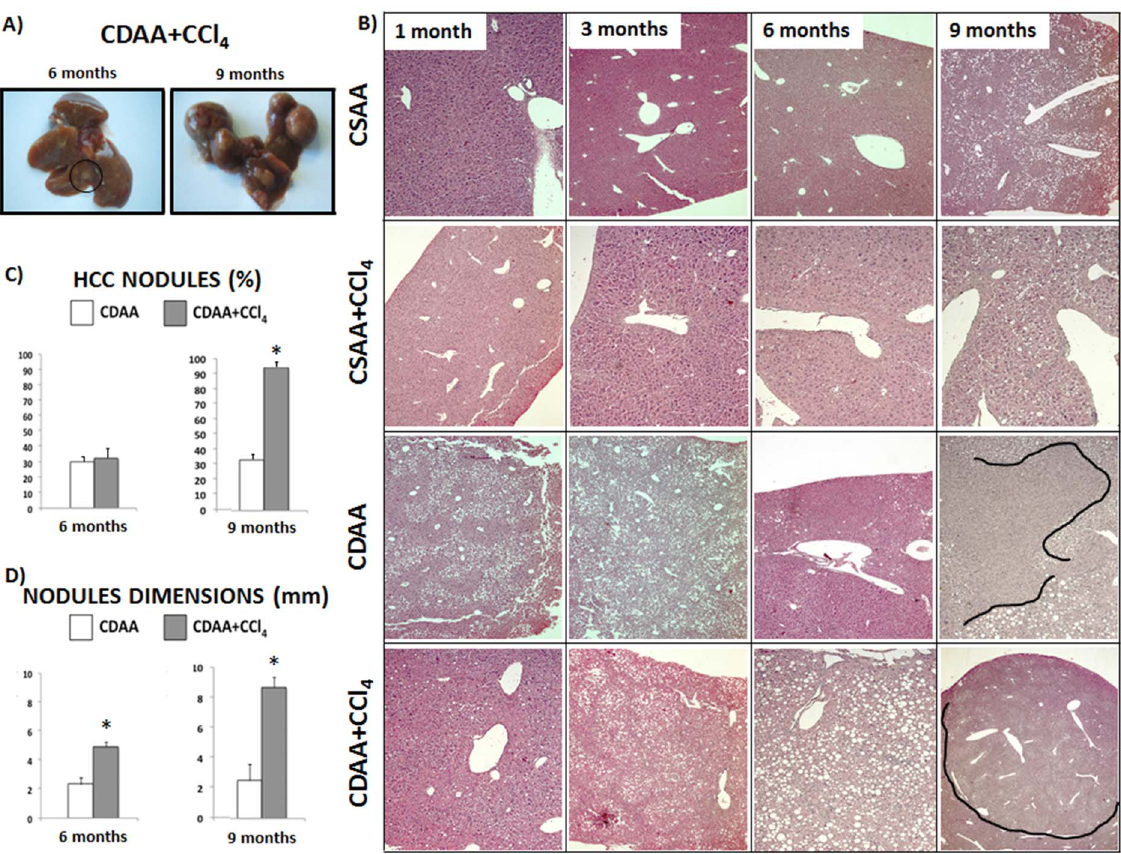
Figure 7. Treatment with CDAA + CCl 4 induces development of HCC after 9 months. A ) Mice sacrificed after 1 and 3 months from the beginning of the treatment do not show any nodular lesions in the parenchyma. Conversely, mice sacrificed after 6 months of treatment show few nodular lesions compatible with HCC. After 9 months of treatment mice show a liver parenchyma completely damaged. B) Histochemical staining for H&E and Sirius Red show respectively no fat deposition and absence of collagen content into the nodules. C) After 6 months of treatment, about 30% of mice show HCC development both with CDAA and CDAA + CCl 4 . After 9 months of treatment, 100% of mice from the CDAA + CCl 4 group show at least one nodule into the liver parenchyma. D) After 6 months, the average of nodules dimension in the group of CDAA mice is significantly lower in comparison to that of the group of CDAA + CCl 4 mice. After 9 months, the average of nodules dimension in the group of CDAA + CCl 4 mice results of 9 mm, in comparison to 3 mm of the group of mice treated with CDAA alone. Data represent mean 6 SD; *p , 0.05 vs